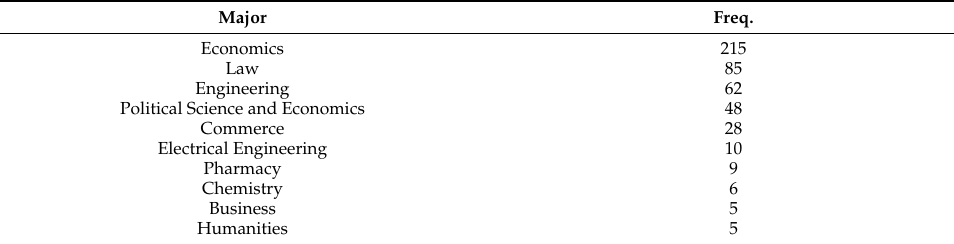
Table A3. Major of CEOs who graduated from universities founded by corporations.